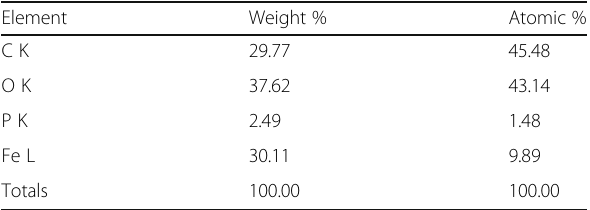
Table 1 The elemental compositions and weight